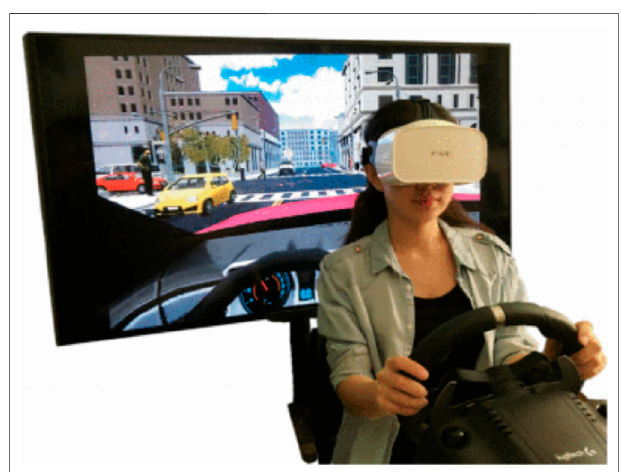
FIGURE 7 | A user improves her driving skills through a personalized VR driving training program. Image courtesy of Lang et al. (2018).